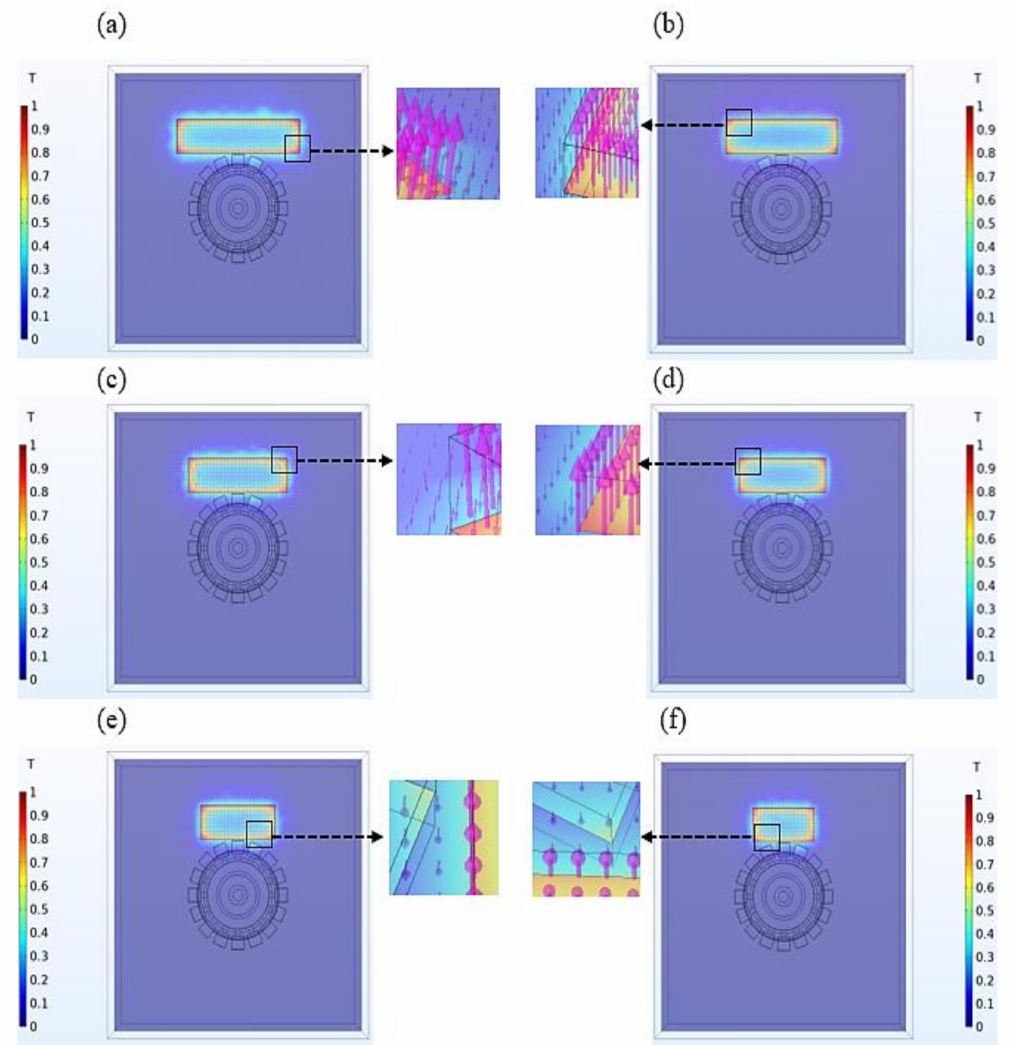
Figure 9. Simulation results of different models of thermomagnetic engine: ( a ) magnetic flux distribution of 100 mm rectangular shape magnet, ( b ) magnetic flux distribution of 90 mm rectangular shape magnet, ( c ) magnetic flux distribution of the optimized size (80 mm) of the magnet, ( d ) magnetic flux distribution of 70 mm rectangular shape magnet, ( e ) magnetic flux distribution of 60 mm rectangular shape magnet, and ( f ) magnetic flux distribution of 50 mm rectangular shape